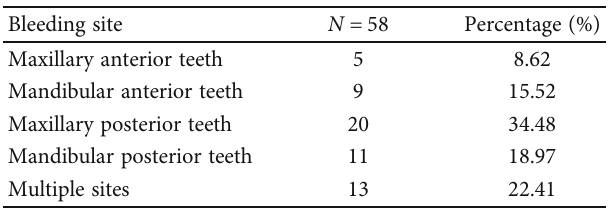
Table 3: Distribution of bleeding teeth after nonsurgical periodontal therapy.